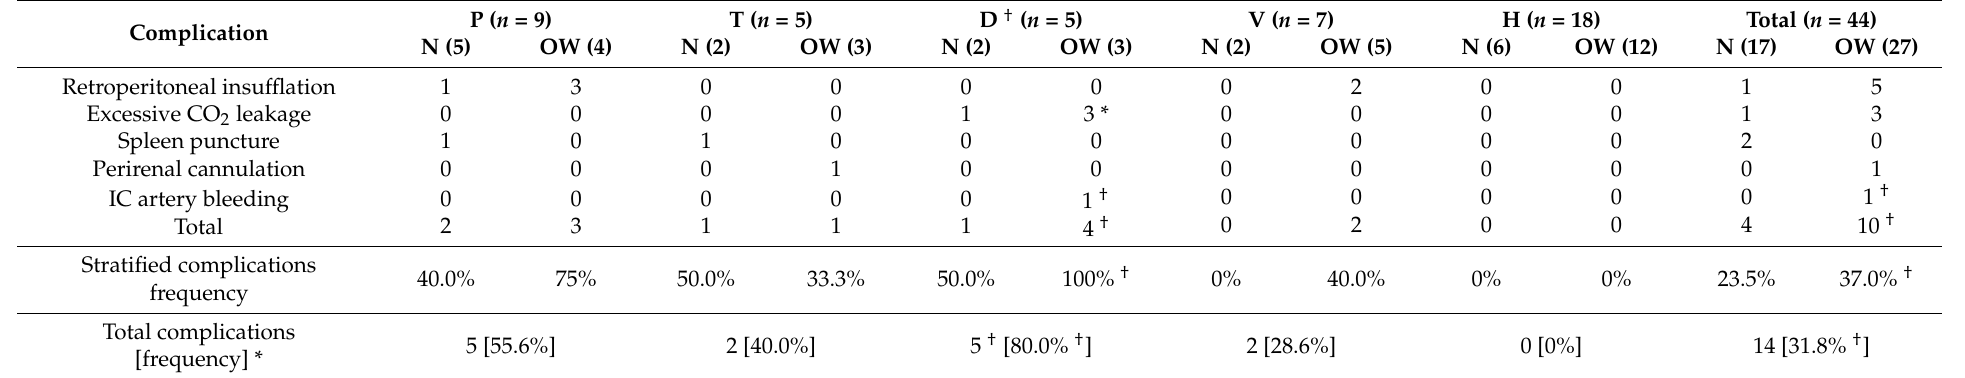
Table 3. Recorded complications in relation to the laparoscopic access method. In parentheses, number of horses without (N) or with overweight (OW).